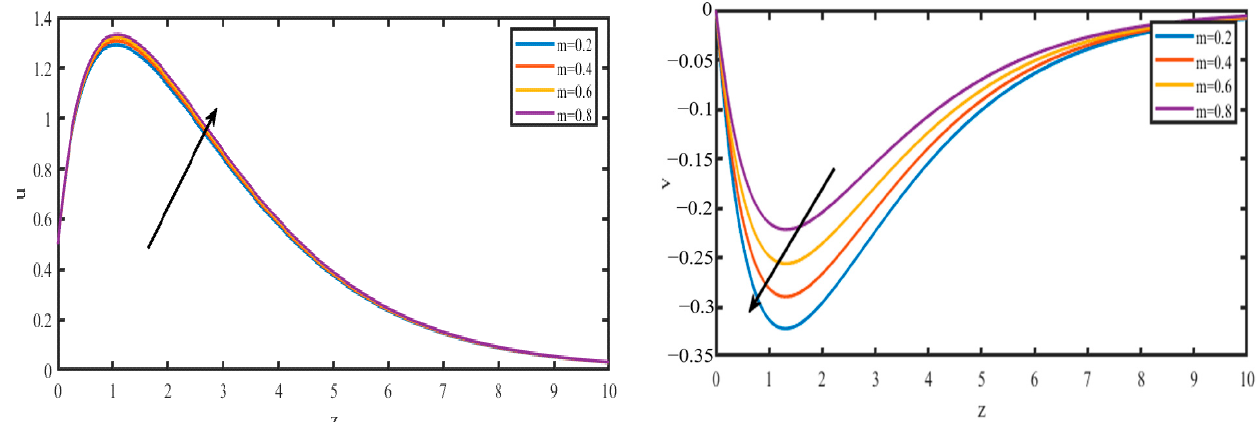
Figure 6. The velocity patterns for u and v plotted vs. R, with k = 0.50, M = 2.0, Gr = 5.0, S = 1.0, Gm = 3.0, m = 0.20, Pr = 0.710, H = 1.0, Sc = 0.220, Kc = 1.0, n = 0.50, t = 0.50, So = 0.50, F = 1.0.